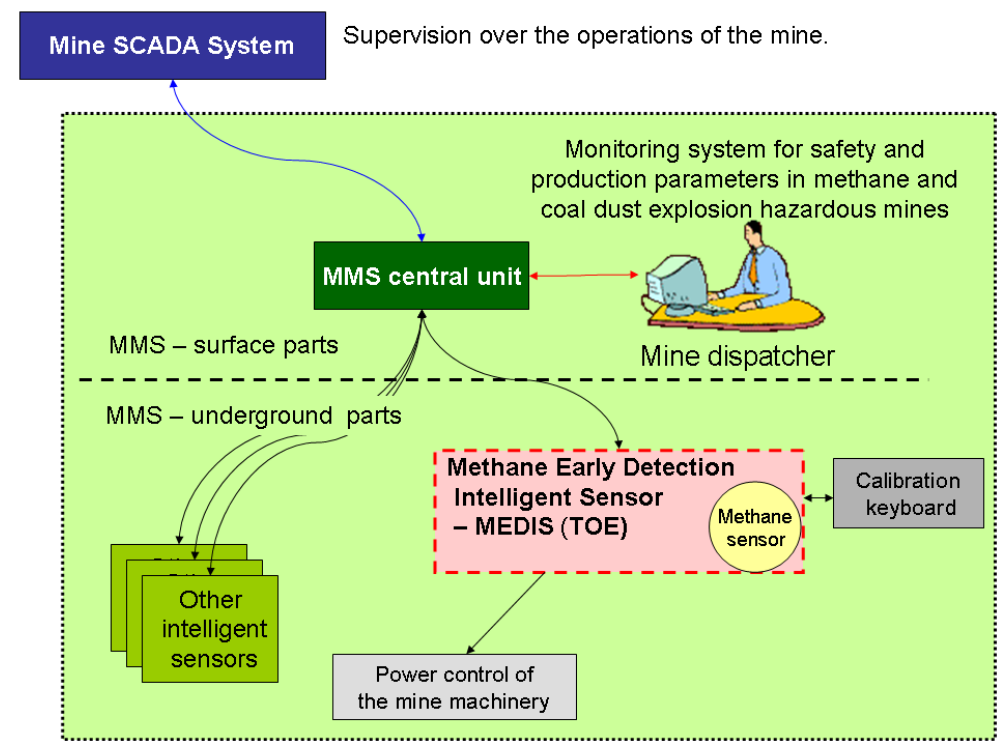
Figure 2. General architecture of the “Mine Monitoring System